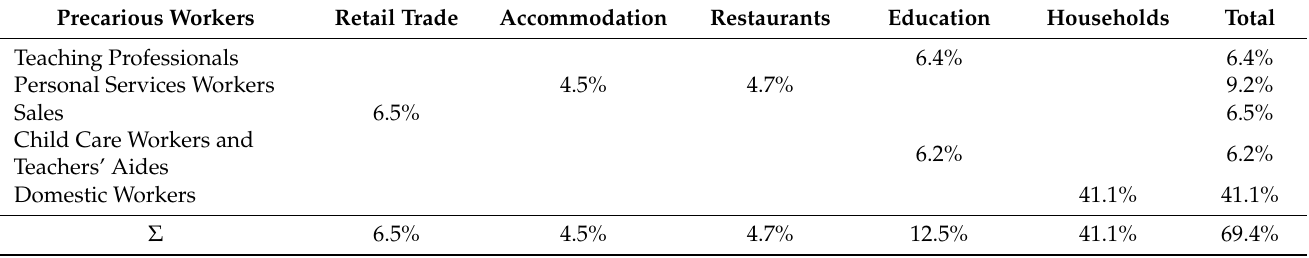
Table 1. Distribution of precarious workers in economic activities and occupations in